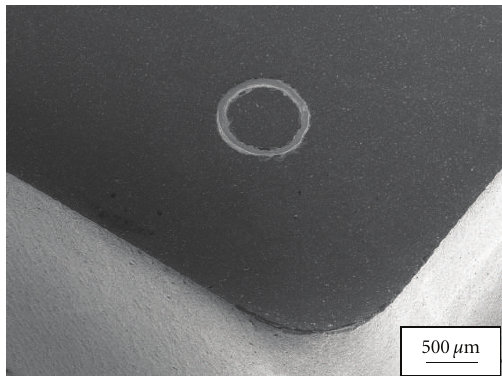
Figure 13: Circular wear track near the cutting edge of a coated cemented carbide insert illustrating the possibility to evaluate small test regions using the present test